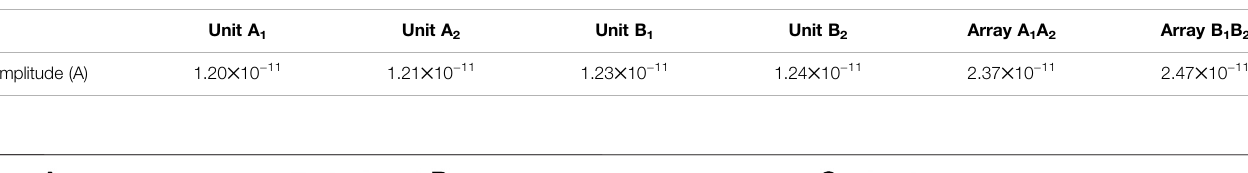
TABLE 1 | Signal amplitudes of photoconductive antenna elements and arrays.